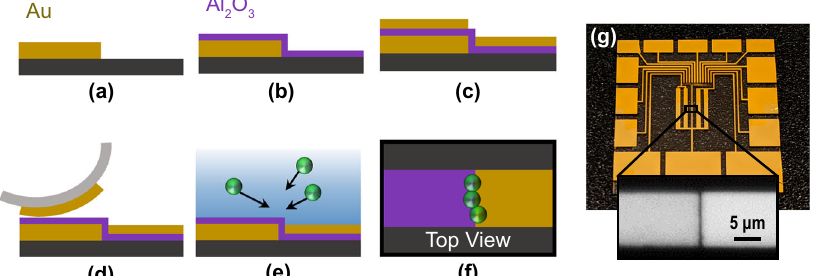
tape. e Solution with the suspended analytes is applied over the whole trap. f Top view of the completed coplanartrap. The ALDAl 2 O 3 layercovers theleftelectrode and the gap between electrodes is de fi ned by the thickness ofthe ALD Al 2 O 3 layer. g A fi naldeviceimageofacoplanararrayofDEPdevices.(inset)Microscopeimage